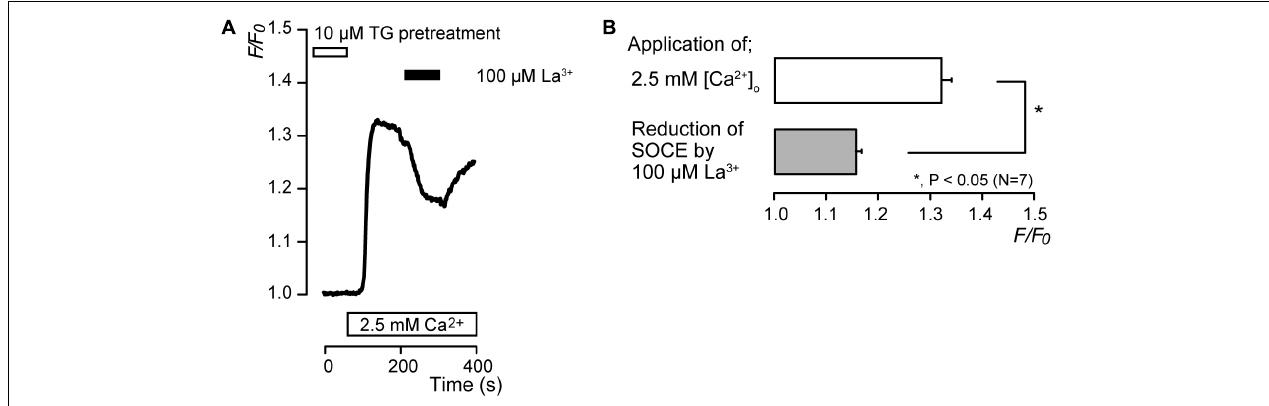
FIGURE 5 | La 3 + inhibits SOCE. (A) Representative trace of the effect of La 3 + on SOCE induced by subsequent application of 2.5 mM extracellular Ca 2 + (white box at bottom) after pre-incubation of 10 µ M TG (white box at the top). Black box shows the time period of 100 µ M La 3 + addition to the extracellular solution. (B) Summary bar graph shows the effect of La 3 + on SOCE (gray column) or the peak F / F 0 values in SOCE activation (open column). Each column indicates the mean ± SE of seven independent experiments. Statistically significant differences between columns (shown by solid lines) are denoted by asterisks, ∗ P <